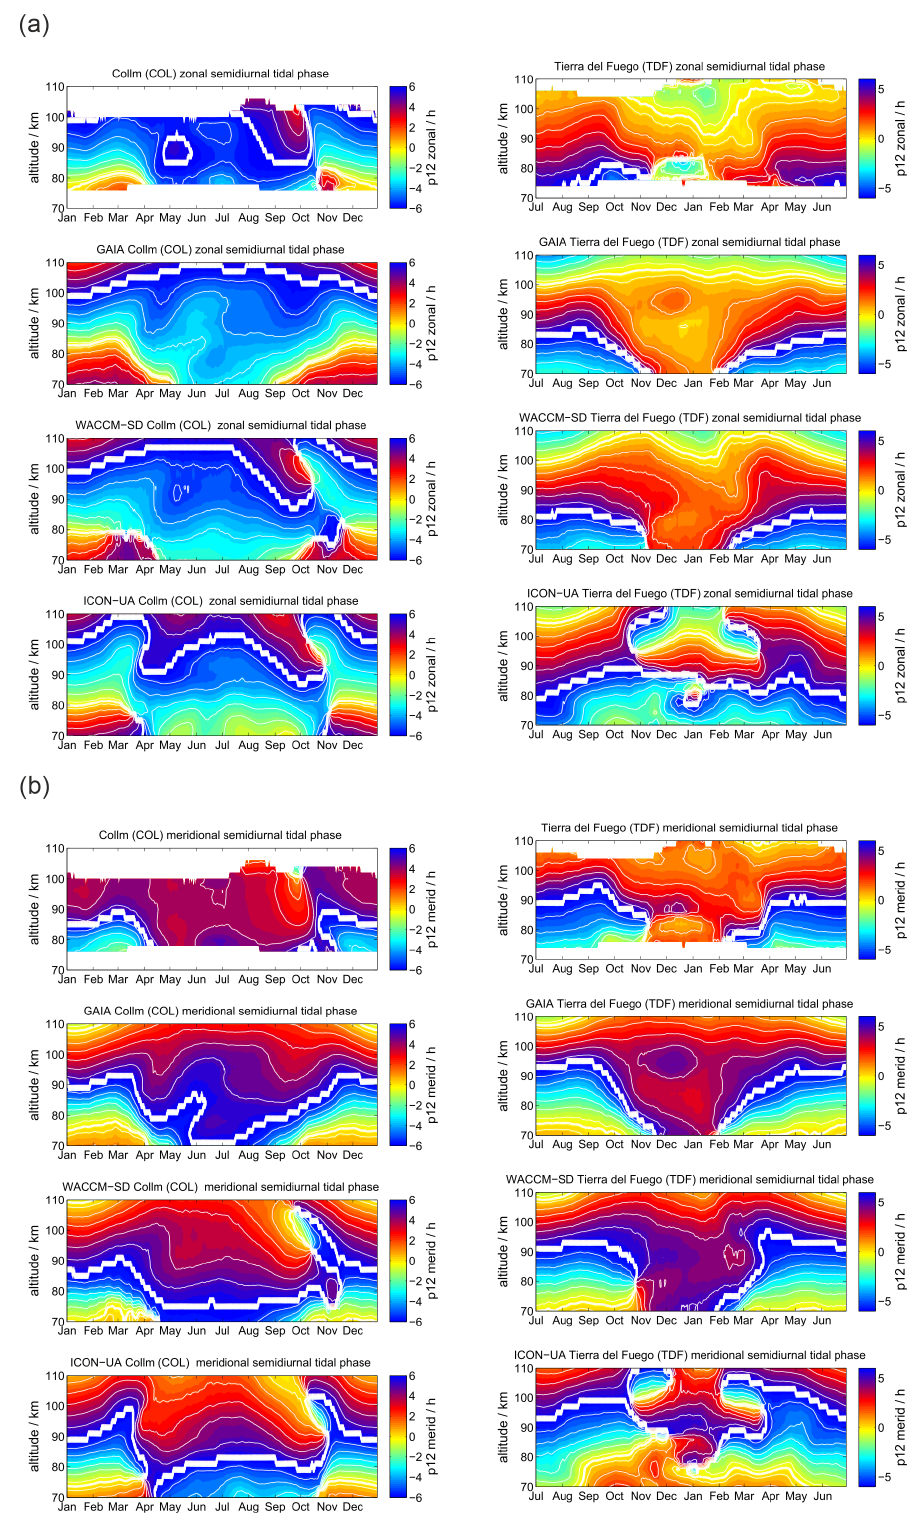
Figure 14. The same as Fig. 2, but for the semidiurnal tidal phases above COL and TDF.